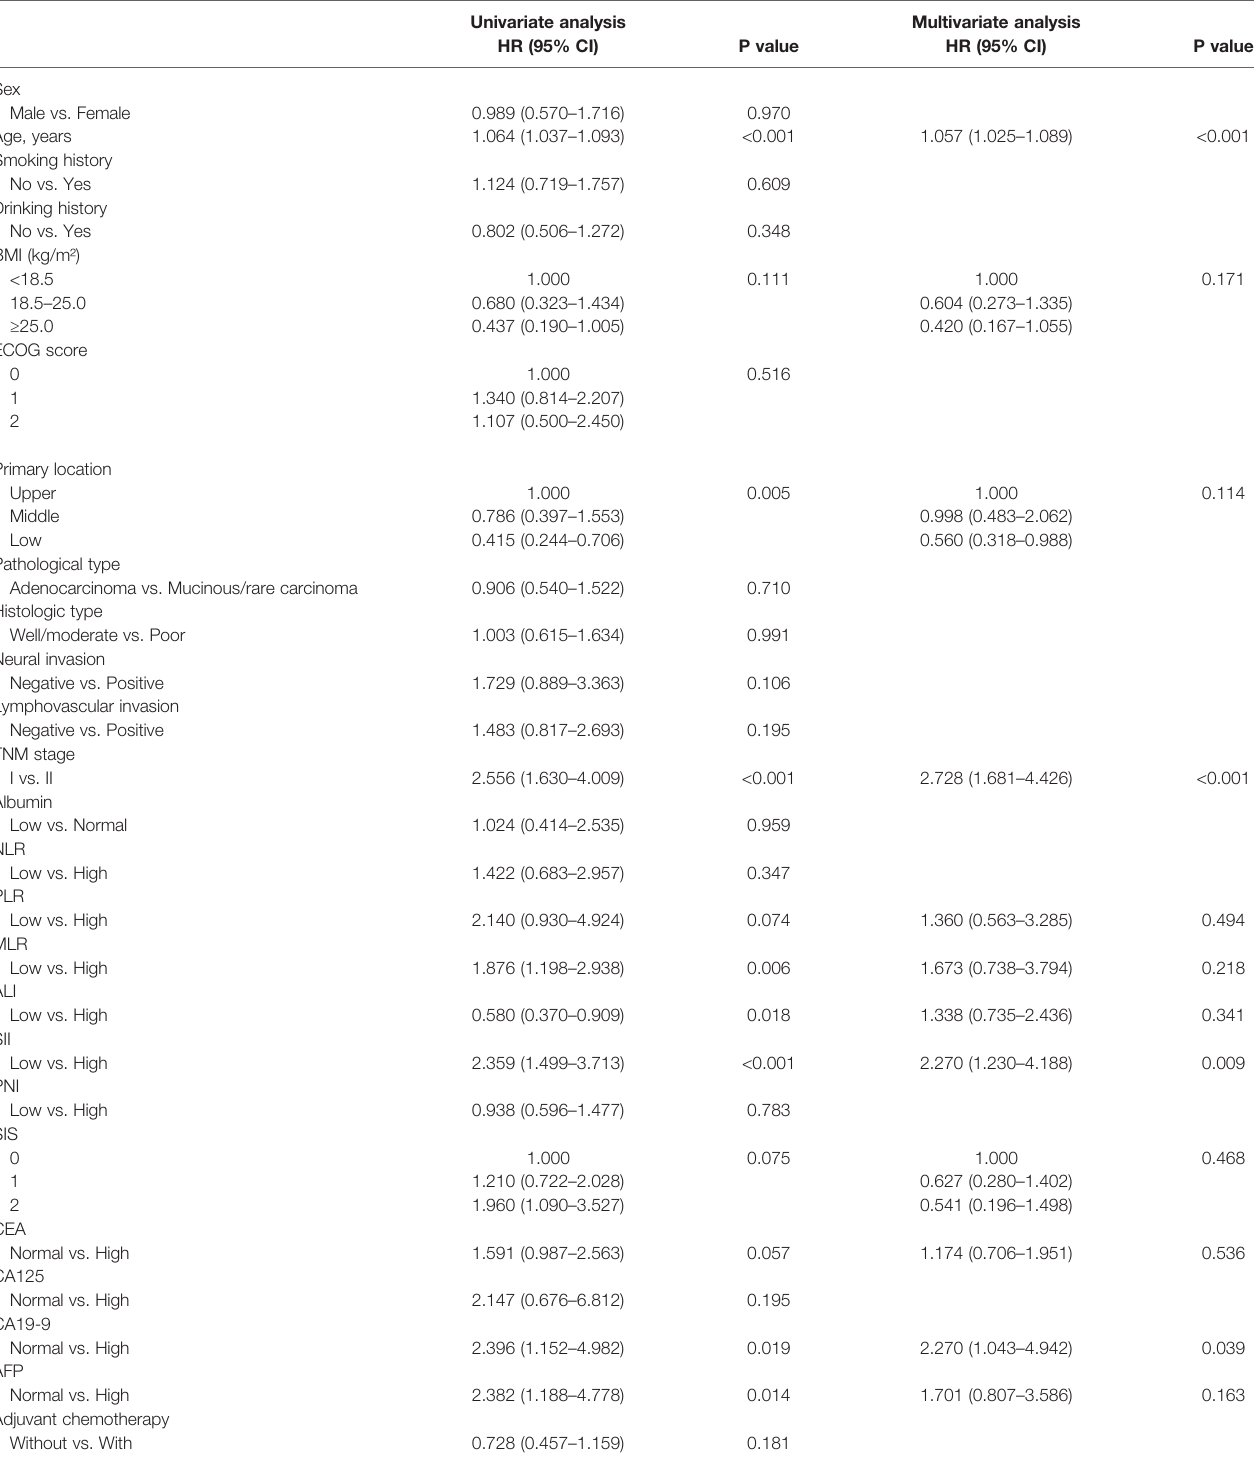
TABLE 4 | Univariate and multivariate analyses of overall survival according to clinicopathologic